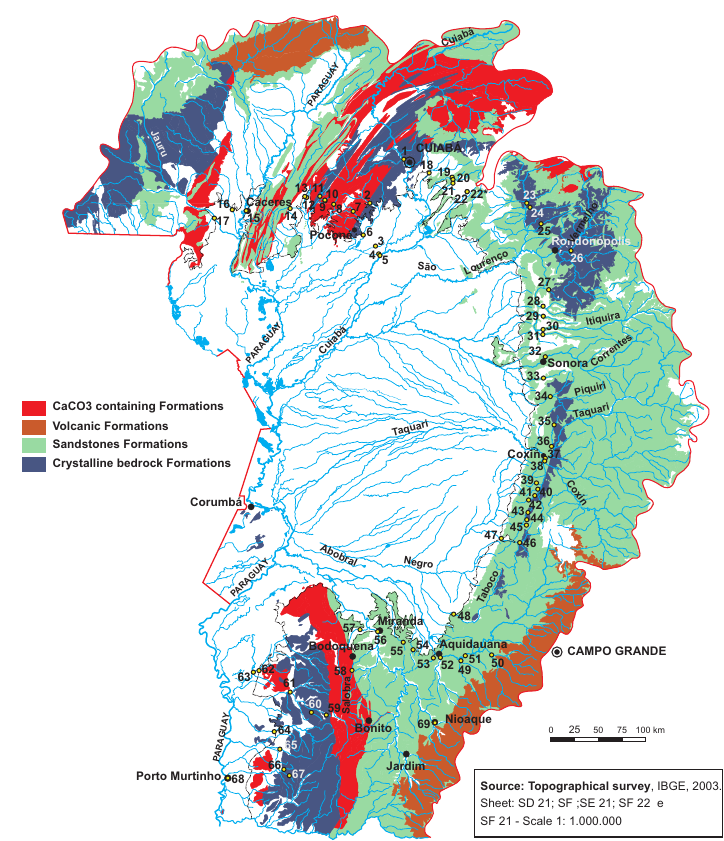
Fig. 13. Simplified map of the lithology of the Upper Paraguay